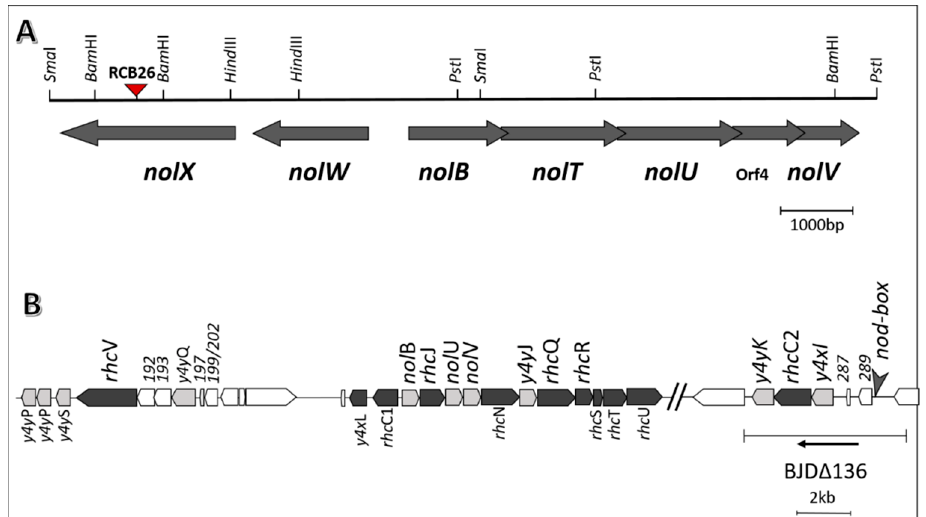
Figure 1. Physical and genetic map of T3SS locus of S. fredii USDA191 ( A ) [39] and B. diazoefficiens USDA110 ( B ) [21]. The position of mini-Mu insertion in NopX (NolX) of USDA191 is shown with a red triangle ( A ). The DNA region deleted in B. diazoefficiens Δ 136 is shown ( B ).